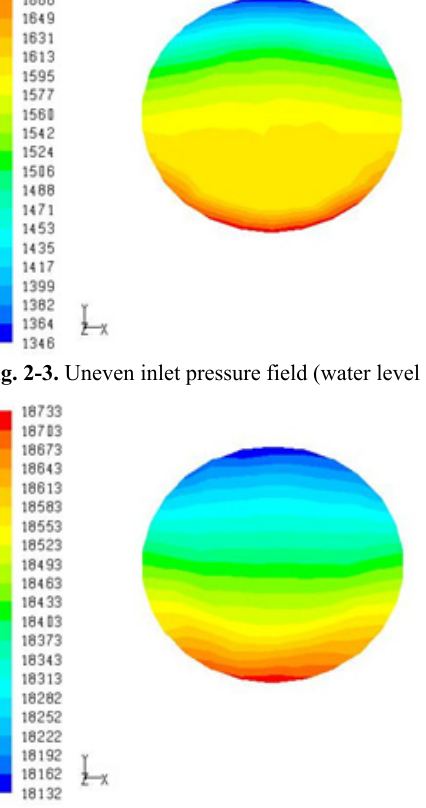
Fig. 2-4. Uneven inlet pressure field (water level of 2.0 m).